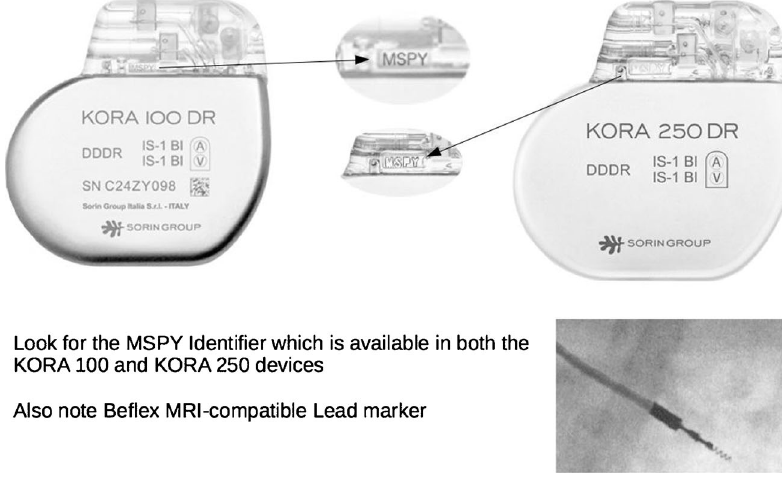
Fig. 10 Sorin Group MRI compatible pacemakers. Look for the MSPYidentifier. (imagesused with